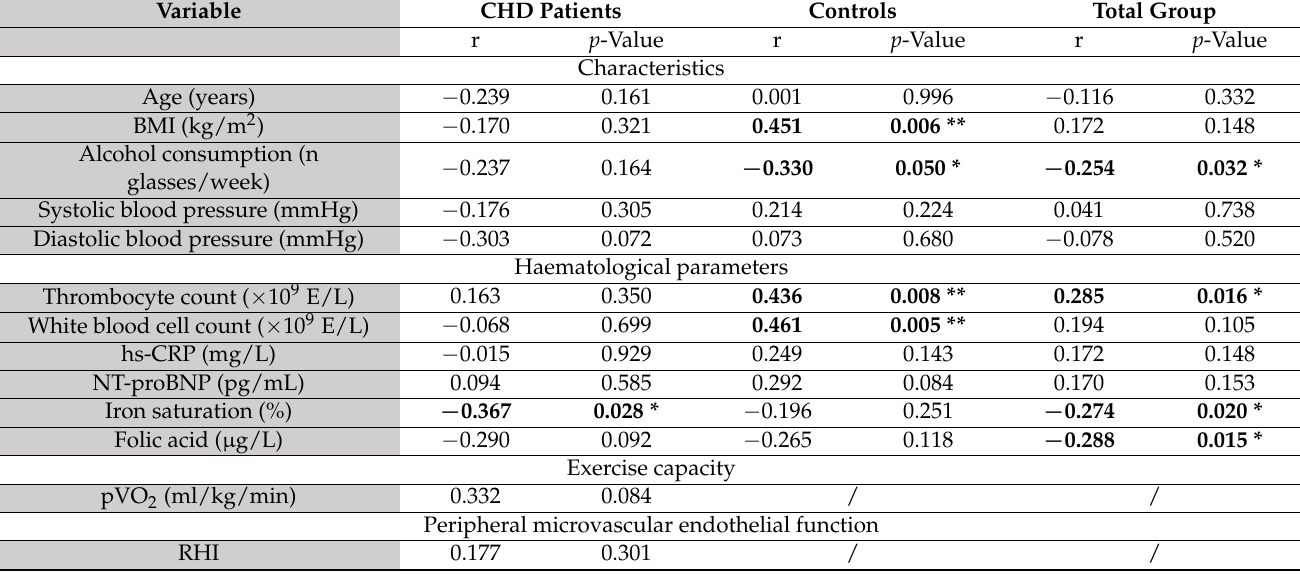
BMI = body mass index, hs-CRP = high-sensitivity C-reactive protein, n = amount, NT = N-terminal-pro hormone B-type natriuretic peptide, pVO 2 (ml/kg/min) = peak oxygen consumption, RHI = reactive hyperemia index. r = Spearman’s rho. * Correlation is significant at the 0.05 level (2-tailed), ** Correlation is significant at the 0.01 level